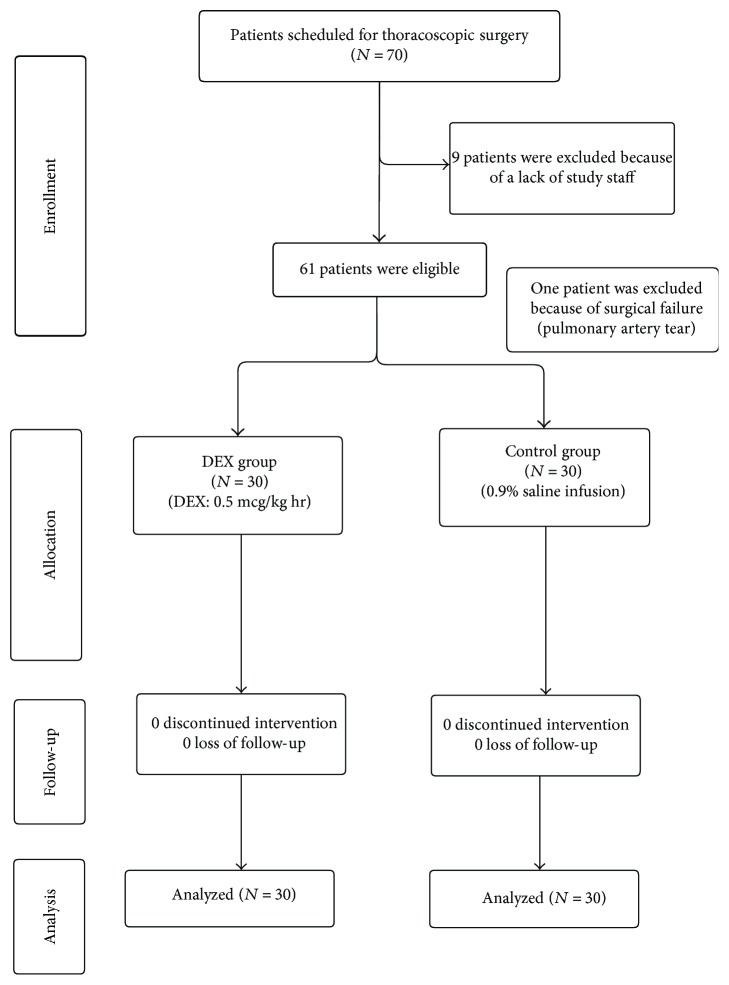
CONSORT diagram.